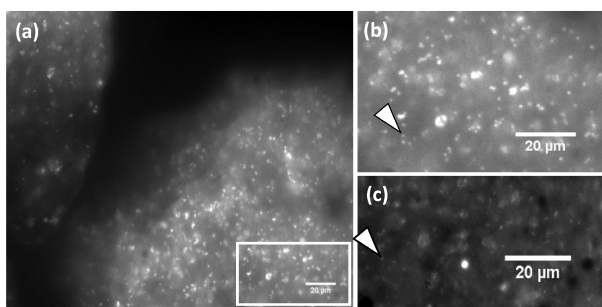
Figure 3. Fluorescence micrograph of a decalcified G. bulloides cell examined under the TRITC filter set (excitation 540nm, emission wavelength >580nm). (a) The cytoplasm from two of the cham- bers is shown. The autofluorescence localised to the ∼ 1µm di- ameter globular structures found throughout the cell is consistent with the presence of phycoerythrin-containing Synechococcus . The white rectangle denotes the area magnified in (b) in which the aut- ofluorescing structures can be seen as discrete entities demonstrat- ing that the cyanobacterial cell membranes are intact (see text). The white arrowheads highlight a group of bacteria that can also be iden- tified by DAPI staining when examined under the DAPI filter set in (c)